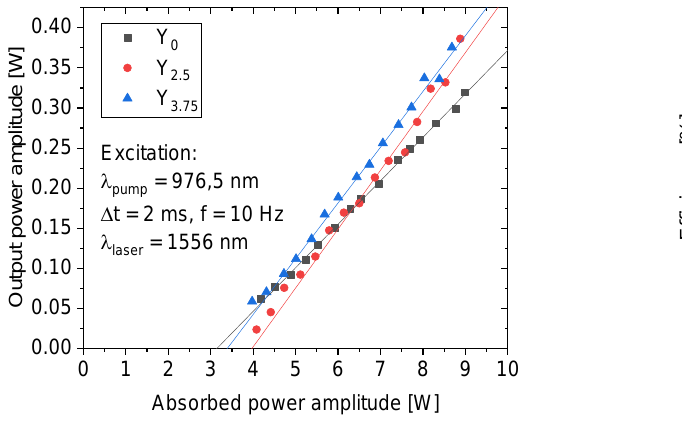
( b ) Figure 9. The emission spectra ( a ) and calculated emission cross-section ( b ) of the glasses. The emission cross-sections were calculated using Equation (2) and are shown in Fig- ure 9b. The emission cross-sections of the newly developed glasses are comparable to those of other Er 3+ -doped phosphate glasses, including commercial ones [13,18,24]. One should notice that both Y-containing glasses exhibit about 20% larger emission cross-sec- tion than that of the glass Y 0 . This result follows the dependencies of the refractive index and the fluorescence lifetime and could be a consequence of Y ions causing a partial re-